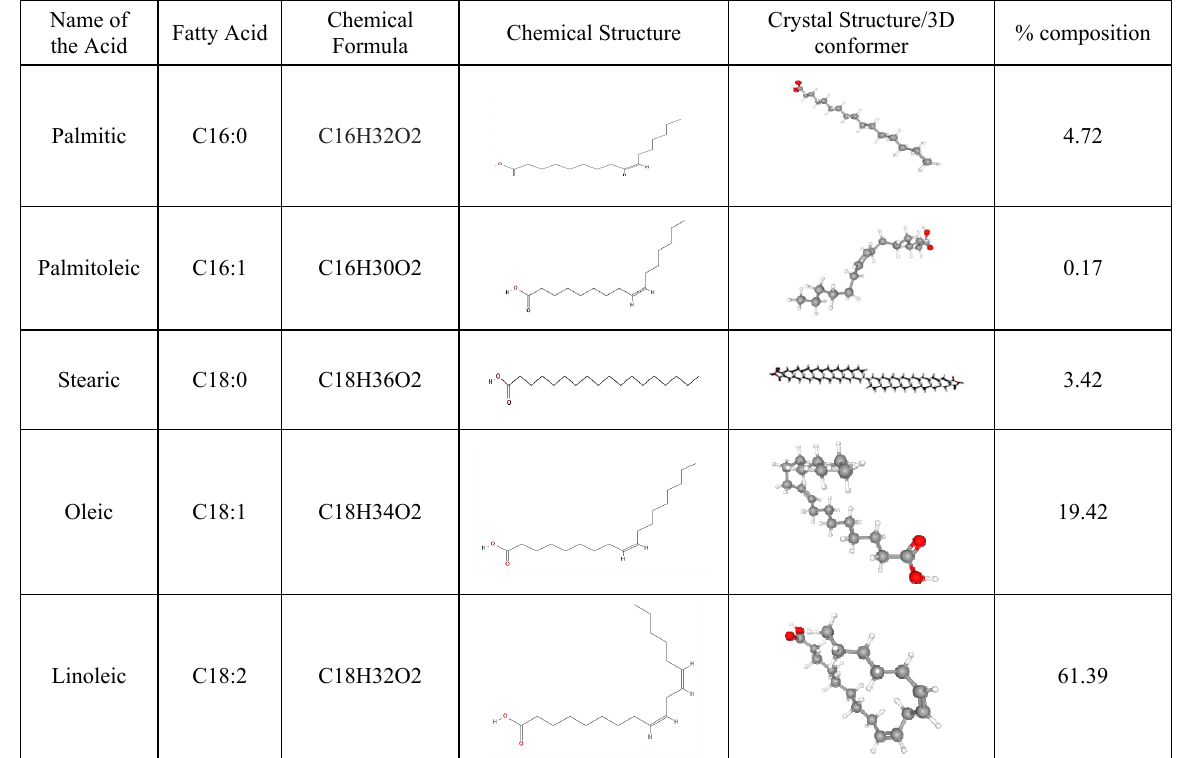
Table 3. Free Fatty Acids of PSSVO Name